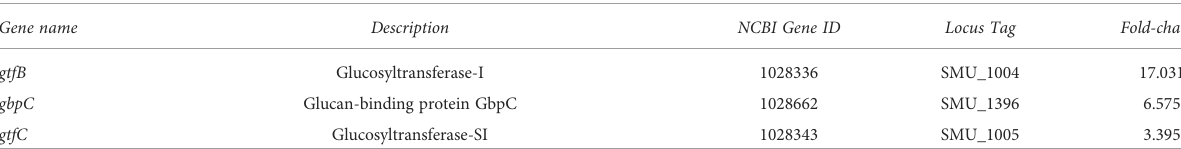
TABLE 3 List of genes whose expression was upregulated (>2-fold) in strain SN74CND compared with parental strain SN74 by RNA-Sequencing. Cell surface protein-related